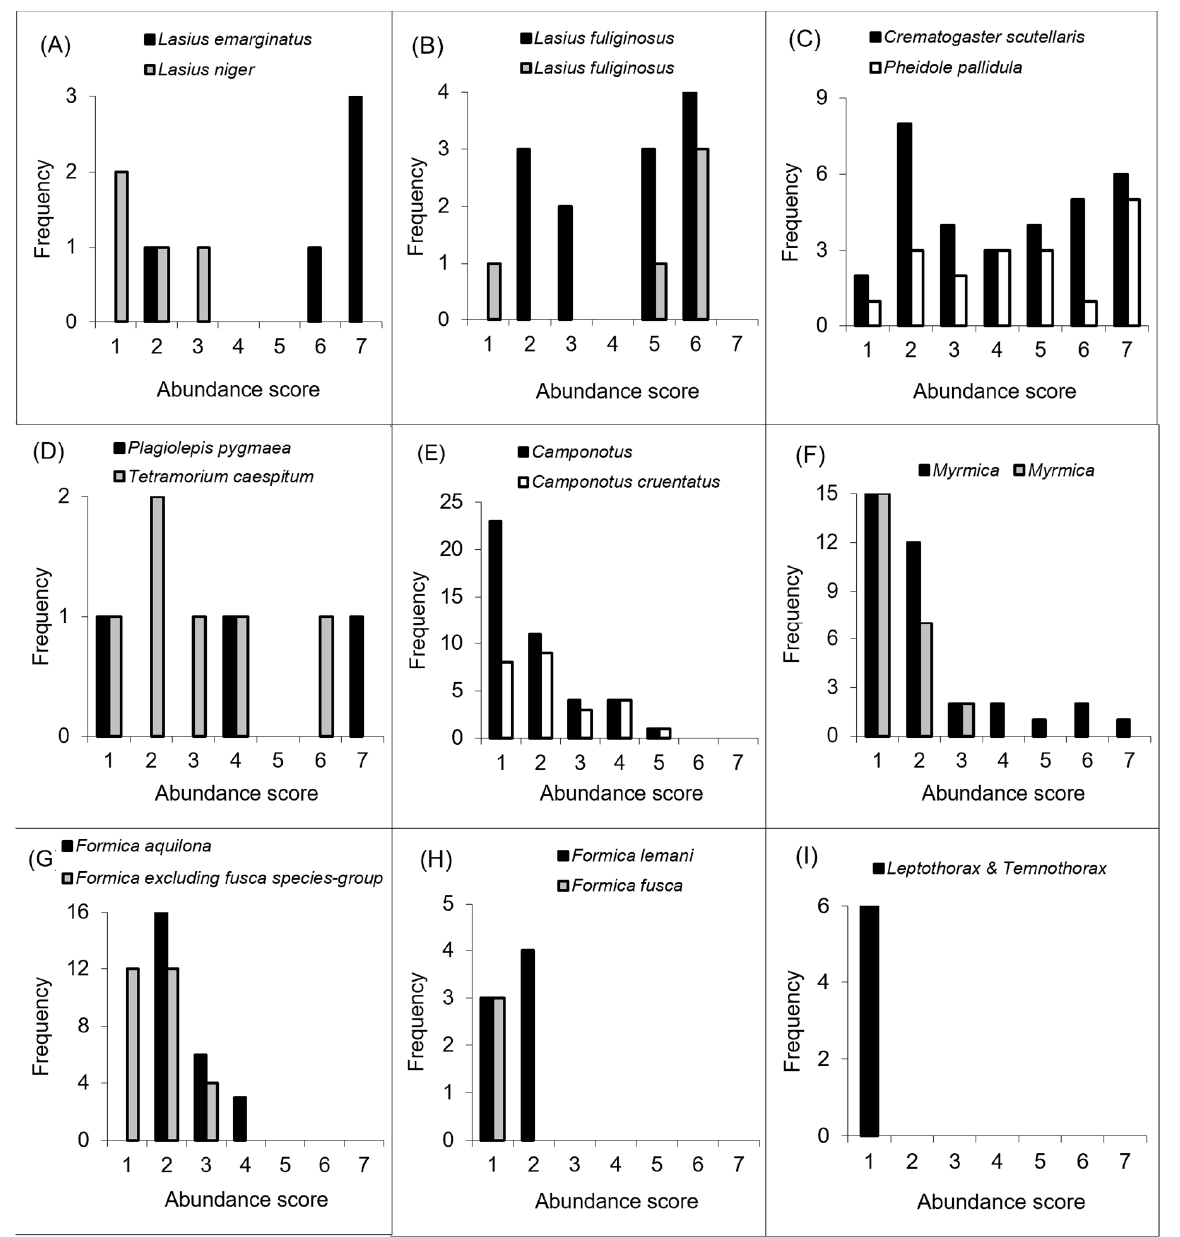
Figure 3. Frequency distributions of abundance scores at baits for all selected taxa ( A – I ); data pooled across sites along the vegetation gradients) in France (black or white) and Denmark (grey). Only 30 min and 60 min observation periods are included.